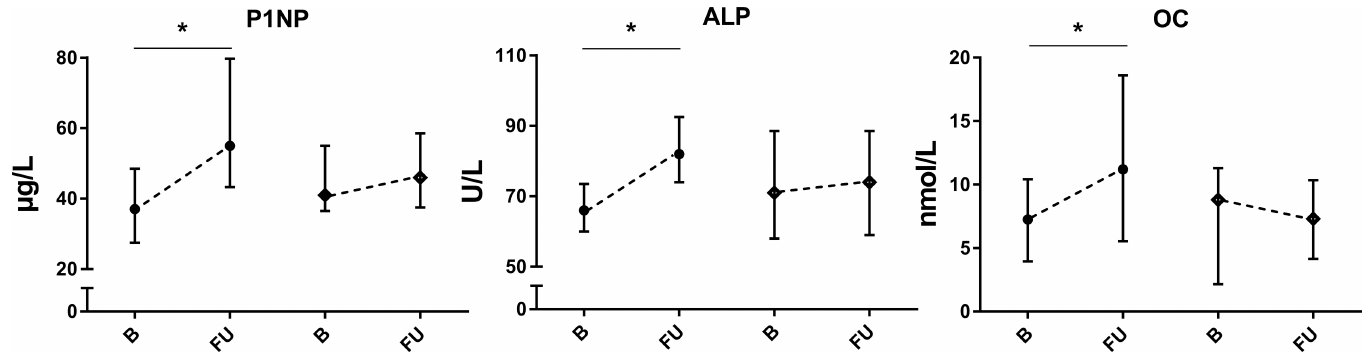
Fig 1. Bone formation markers in PHI-men, (cid:3) = significant difference p (cid:20) 0.05 of follow-up versus baseline, ● = cART treated group, ◆ = untreated group, B = baseline, median and IQR, FU = follow-up, median and IQR.